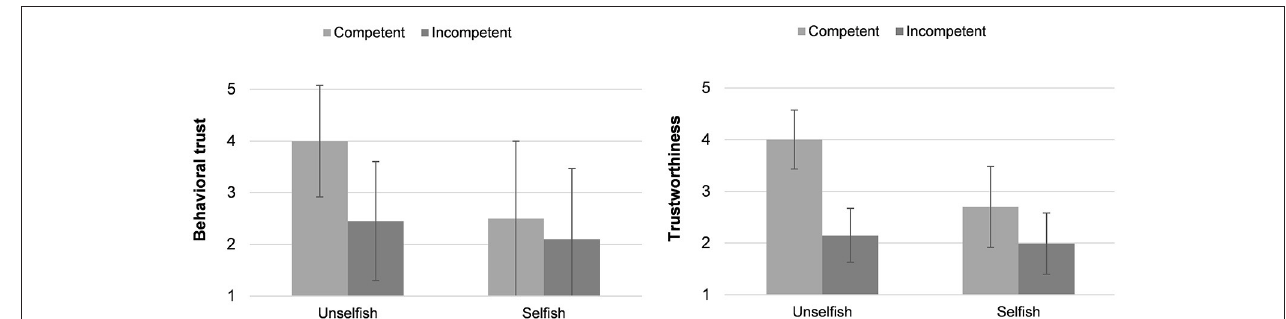
FIGURE 3 | Behavioral trust and trustworthiness means. Error bars represent standard deviations.